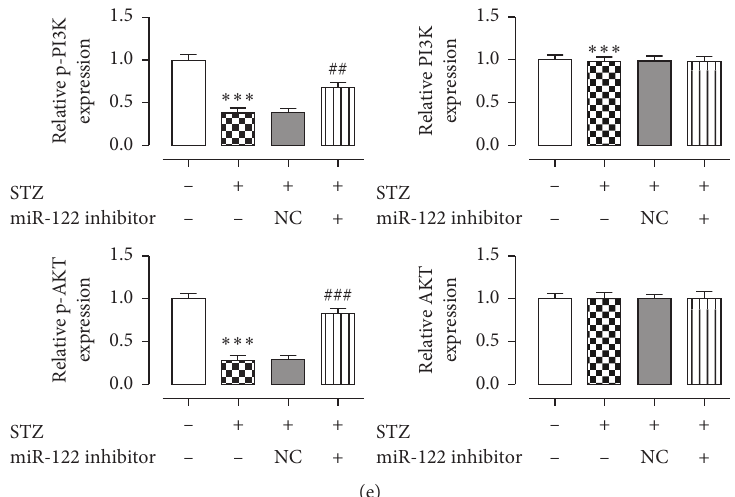
Figure 2: Inhibition of MiR-122 decreases cell apoptosis. (a) TUNEL staining was used to detect cell apoptosis. (b, c) Expression levels of the apoptosis-related proteins Bcl-2, Bax, cleaved caspase-3, cleaved caspase-9, procaspase-3, and procaspase-9 were analyzed using western blotting. (d, e) Interference with miR-122 activates the pI3K/AKT signaling pathway in pancreatic β cells induced by STZ. ∗ P < 0 . 05, ∗∗ P < 0 . 01, ∗∗∗ P < 0 . 001 versus control group; # P < 0 . 05, ## P < 0 . 01, ### P < 0 . 001 versus STZ group. The experiment was repeated three